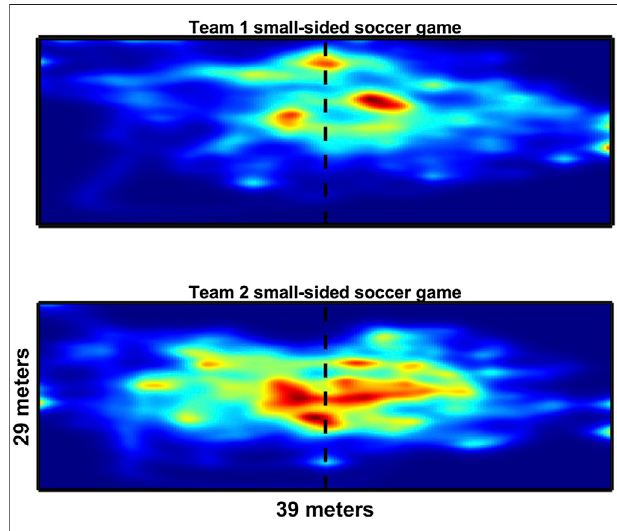
FIGURE 10 | Heatmap representation of the two teams (4 vs 4) during 5 min of gameplay in a small-sided soccer